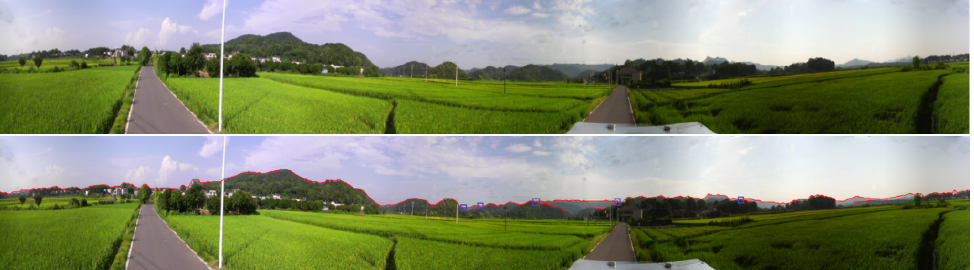
Figure 21. The effect of the extraction skyline and lapel points. Red curve denotes the skyline and the ridge lines, where the top red curve is the skyline, and a blue square denotes a lapel point after manual verification and the ambiguous or incorrect lapel points are